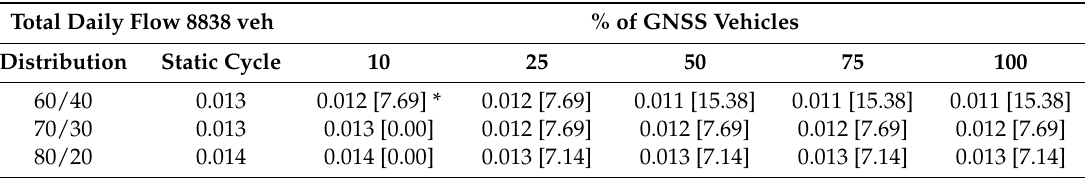
Table 11. Average PM pollution [g/km], in a typical day, for Case A.